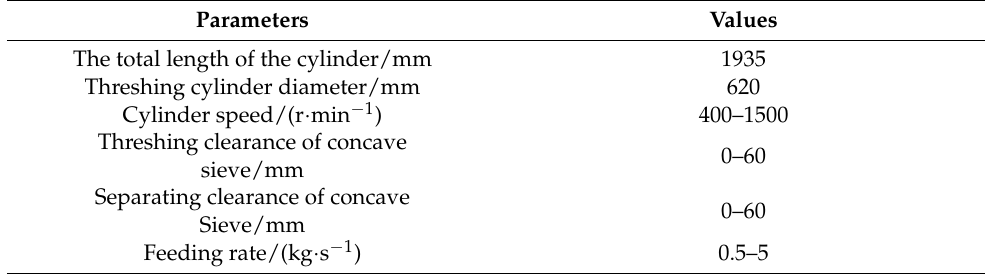
Table 2. Parameter table of flexible threshing